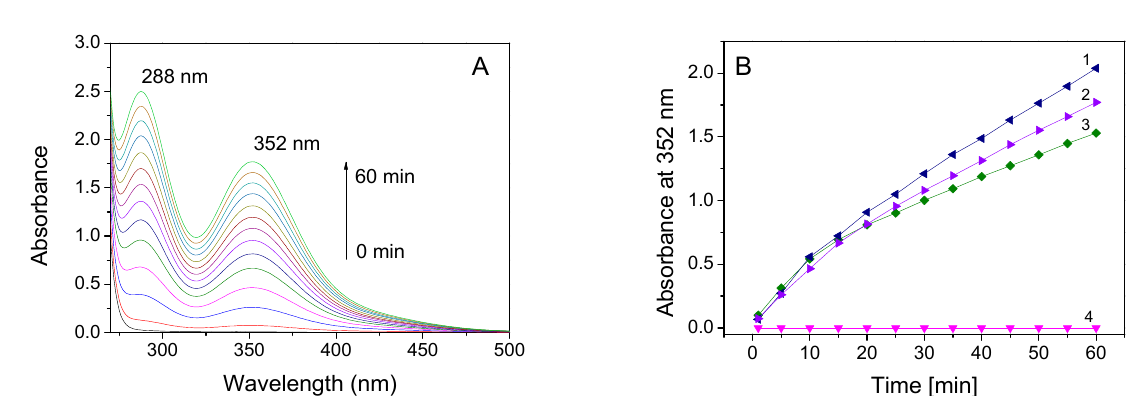
Figure 8. ( A ) Absorption spectra of 0.5 M KI photo-oxidized to I 3 − in the presence of cotton fabric D2 treated with dendrimer, as a function of irradiation time. ( B ) Dependence of the absorbance at 352 nm, during the irradiation of cotton fabrics CR2I (1), D2 (2), C2 (3) and dyed fabrics kept in the dark (4).